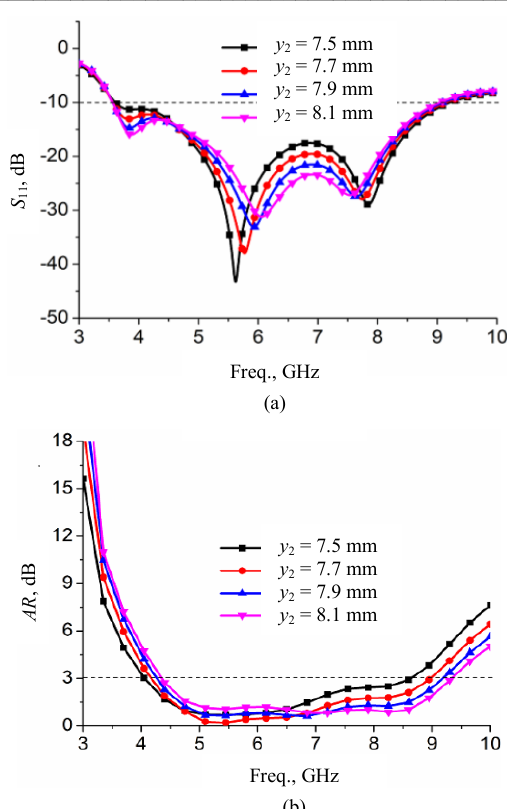
Fig. 9. Effect of ‘ y 2 ’ on impedance bandwidth and axial ratio.